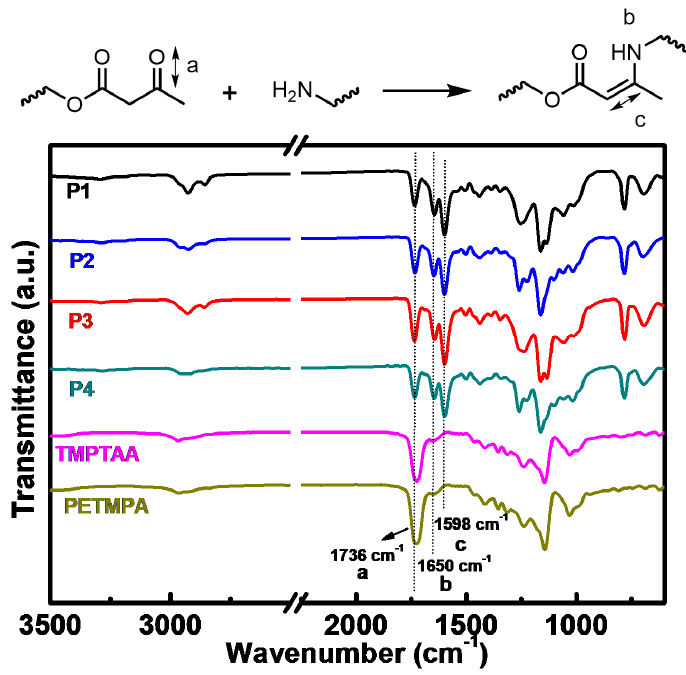
Figure 3. FT-IR spectra of TMPTAA, PETMPA and polymer Figure 3. FT ‐ IR spectra of TMPTAA, PETMPA and polymer films. Table 2. Film swelling data.